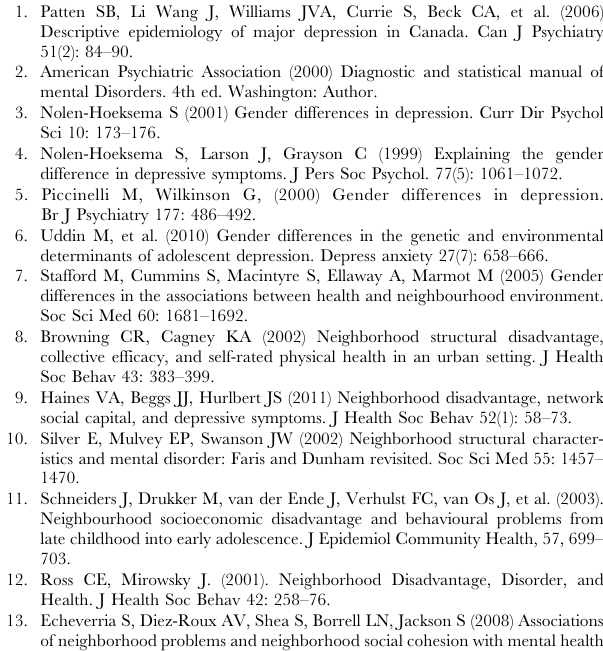
Table S1 Characteristics of Montreal Neighbourhood Networks and Healthy Aging study (MoNNET-HA), social capital and depressive symptoms sample, n = 2574. Table S2 Adjusted odds ratio and 95% confidence intervals of socio-demographic characteristics from multilevel logistic regression analyses, MoNNET-HA Men, n = 912 (Model 1a and Model 2a). Table S3 Adjusted odds ratio and 95% confidence intervals of socio-demographic characteristics from multilevel logistic regression analyses, MoNNET-HA Women, n = 1662 (Model 1b and Model